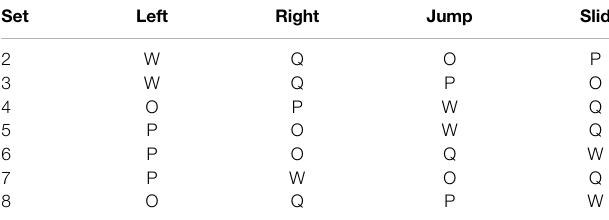
TABLE 1 | Unintuitive control schemes for each set of